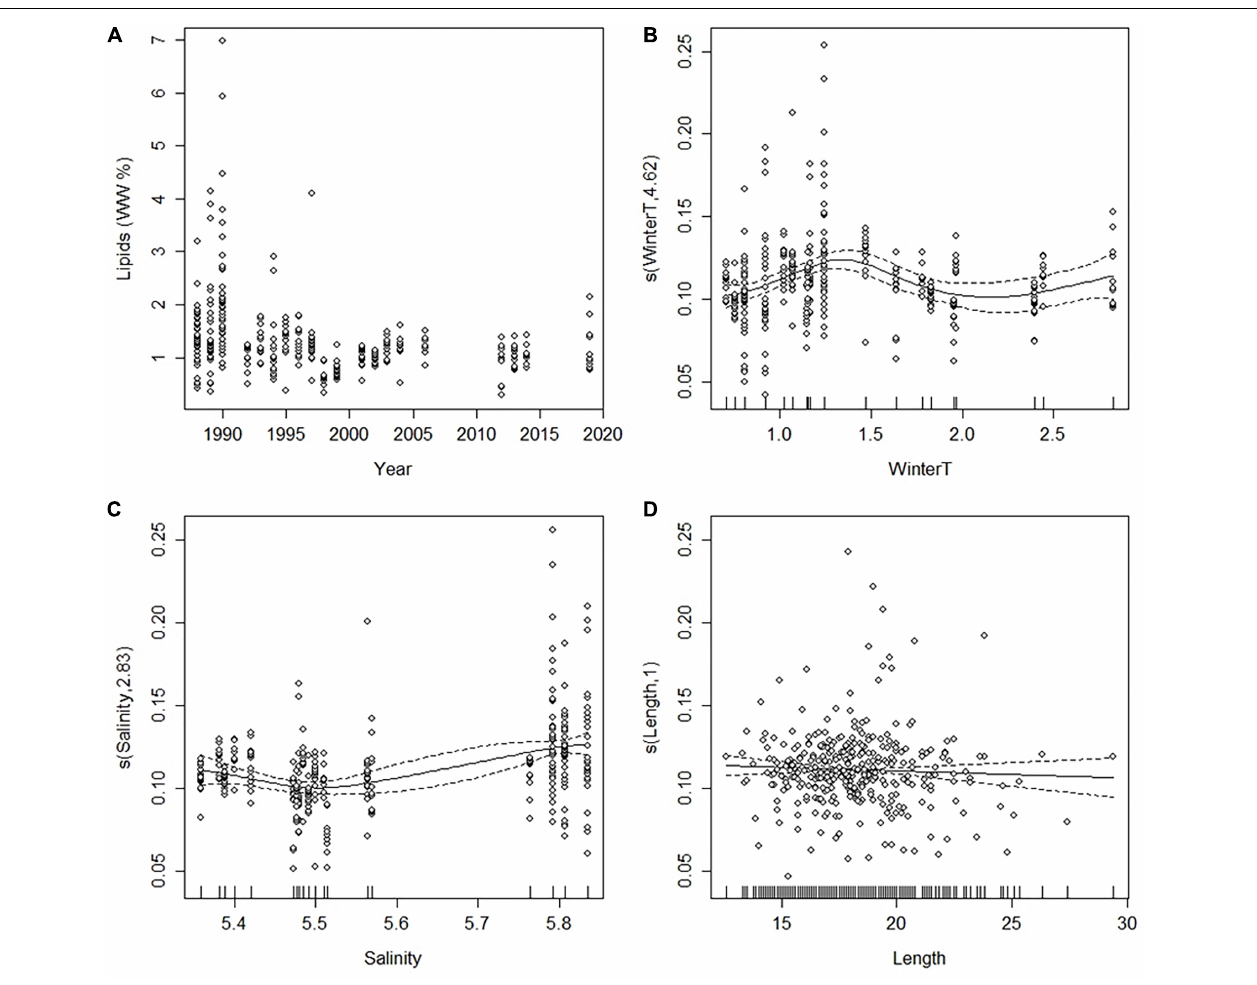
FIGURE 3 | (A) The concentration of lipids (% WW) in the ovarian tissue of the Baltic herring in 1988–2019 (original data); and (B–D) generalized additive mixed model (A) plots showing the partial effects of selected explanatory variables on the arcsine-transformed concentration of lipids. The tick marks on the x-axis are observed data points. The y-axis represents the partial effect of each variable. The dotted lines indicate the 95% confidence intervals. WinterT = water temperature ( ◦ C) in January-April. See text for further